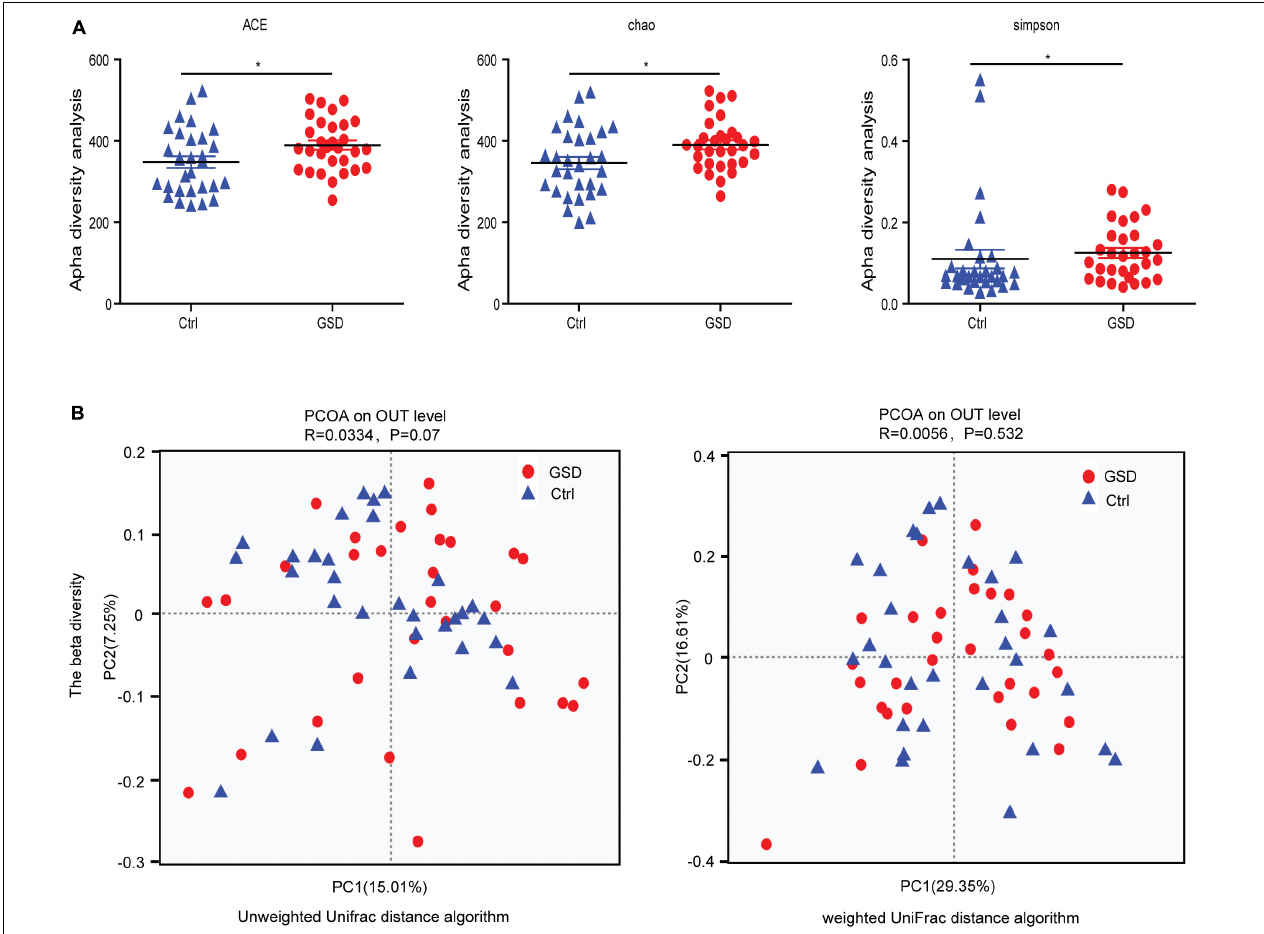
FIGURE 1 | Microbial community characteristics generated by 16SrDNA sequencing. (A) Boxplots of the alpha-diversity indices in the asymptomatic gallstone patients and controls. From left to right, observed ACE, Chao, and Simpson index. (B) Principal coordinates analysis showed the composition of the asymptomatic gallstone patients and controls. * P <